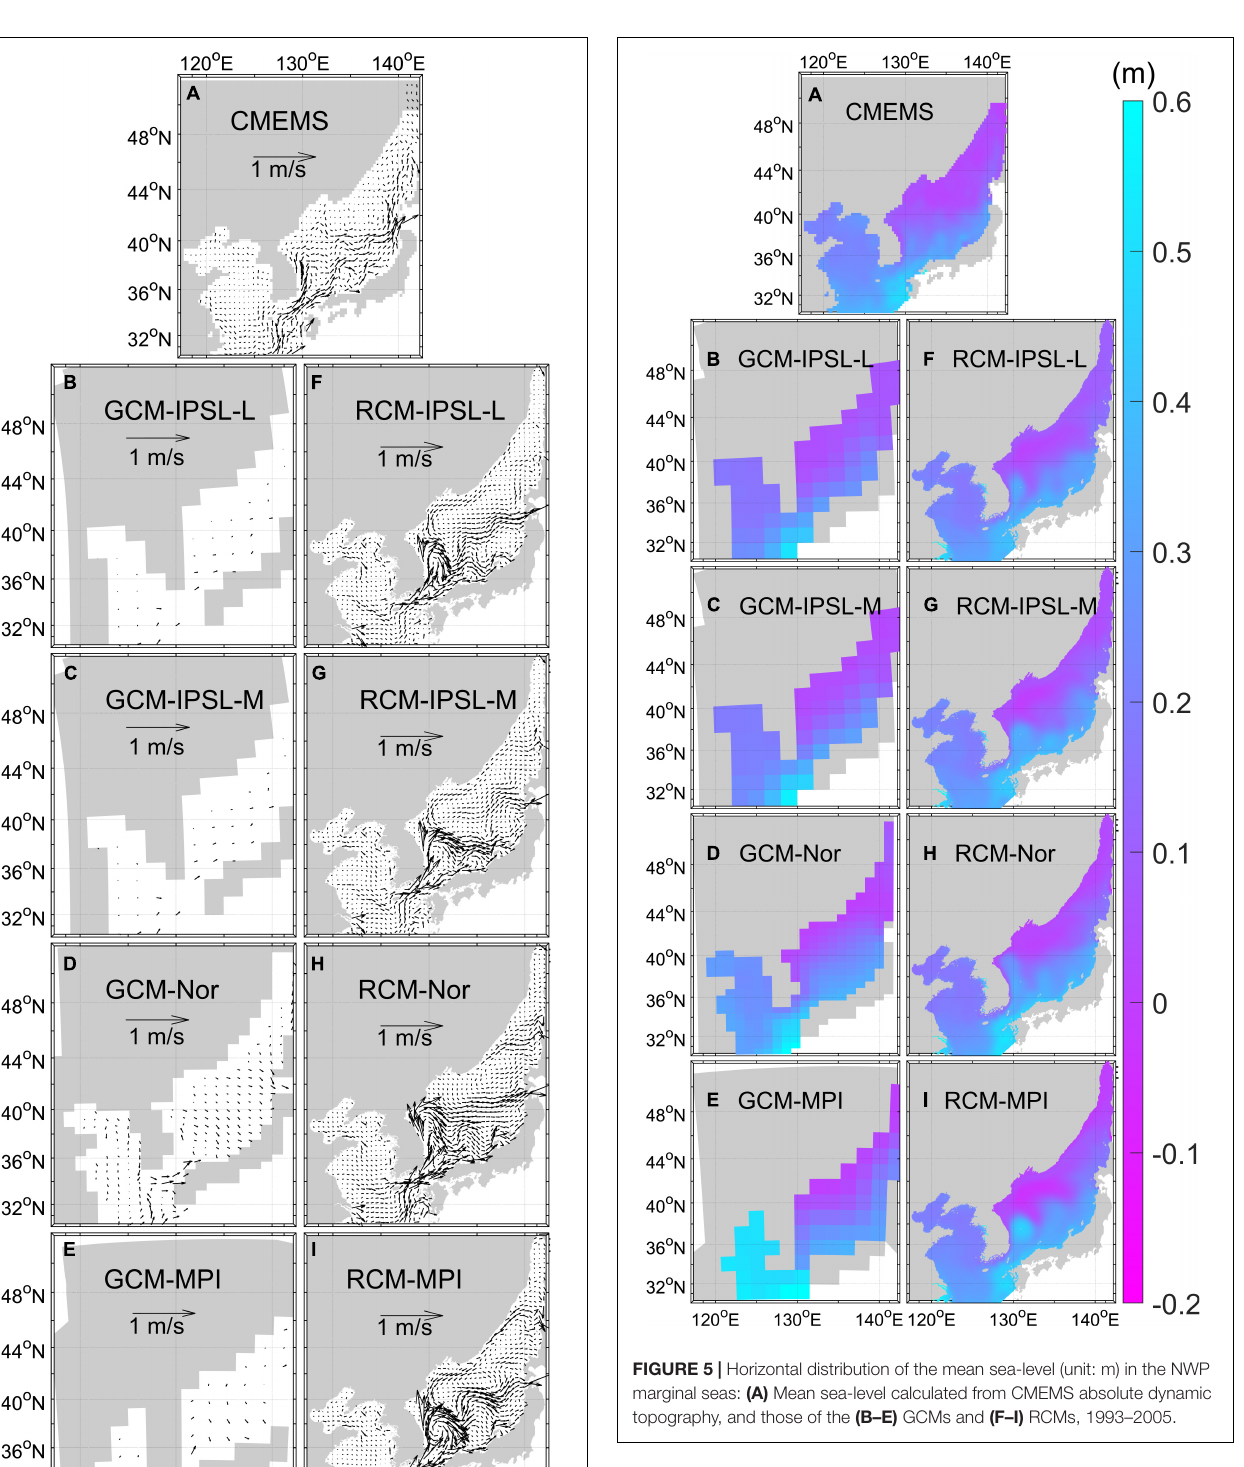
data were obtained from the Earth Topography 1 arc minute (ETOPO1) dataset and interpolated into the RCM grid points (Amante and Eakins, 2009). For clarity, the simulations of IPSL-CM5A-LR, IPSL-CM5A- MR, NorESM1-M, and MPI-ESM-LR are hereafter referred to as GCM-IPSL-L, GCM-IPSL-M, GCM-Nor, and